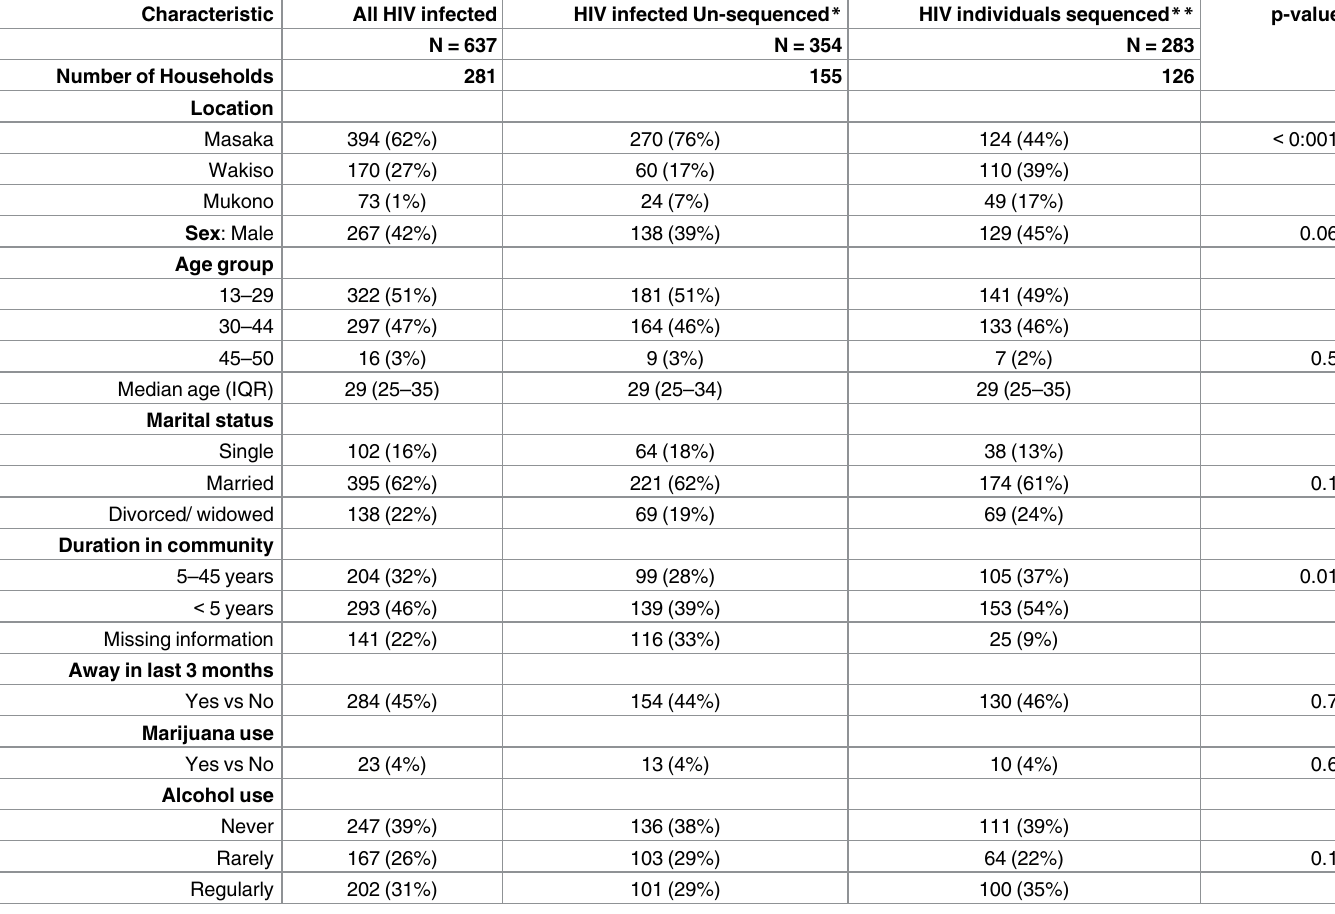
Table 1. Summaryof baseline characteristics for the 3 lakeshore districts surveyedin 5 fishing communities between 2009–2011.